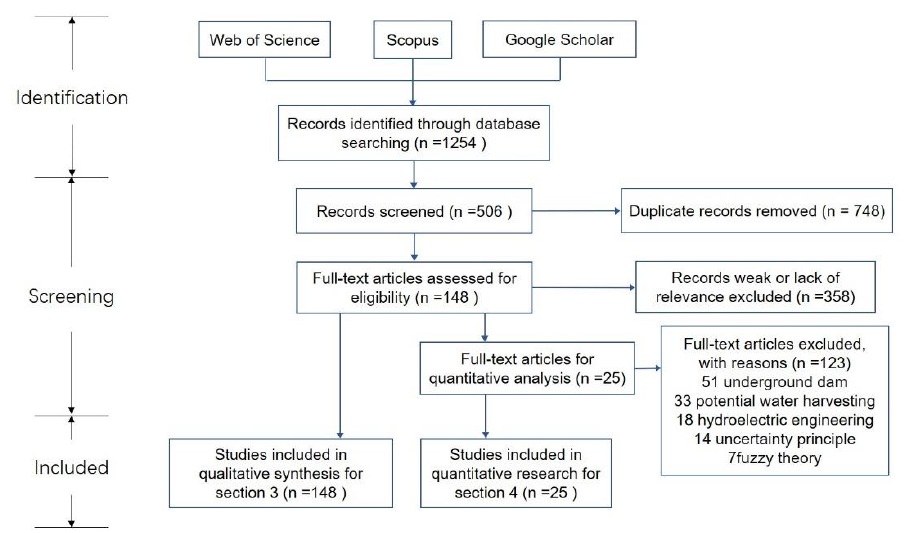
Figure 1. Flowchart for paper selection process. Table 1. Key elements in data collection.